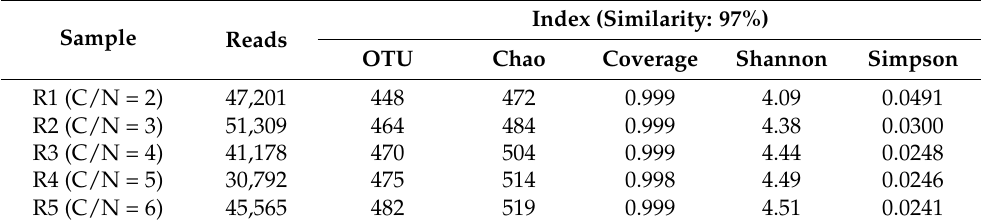
Table 1. Alpha diversity of biofilm under different influent C/N.